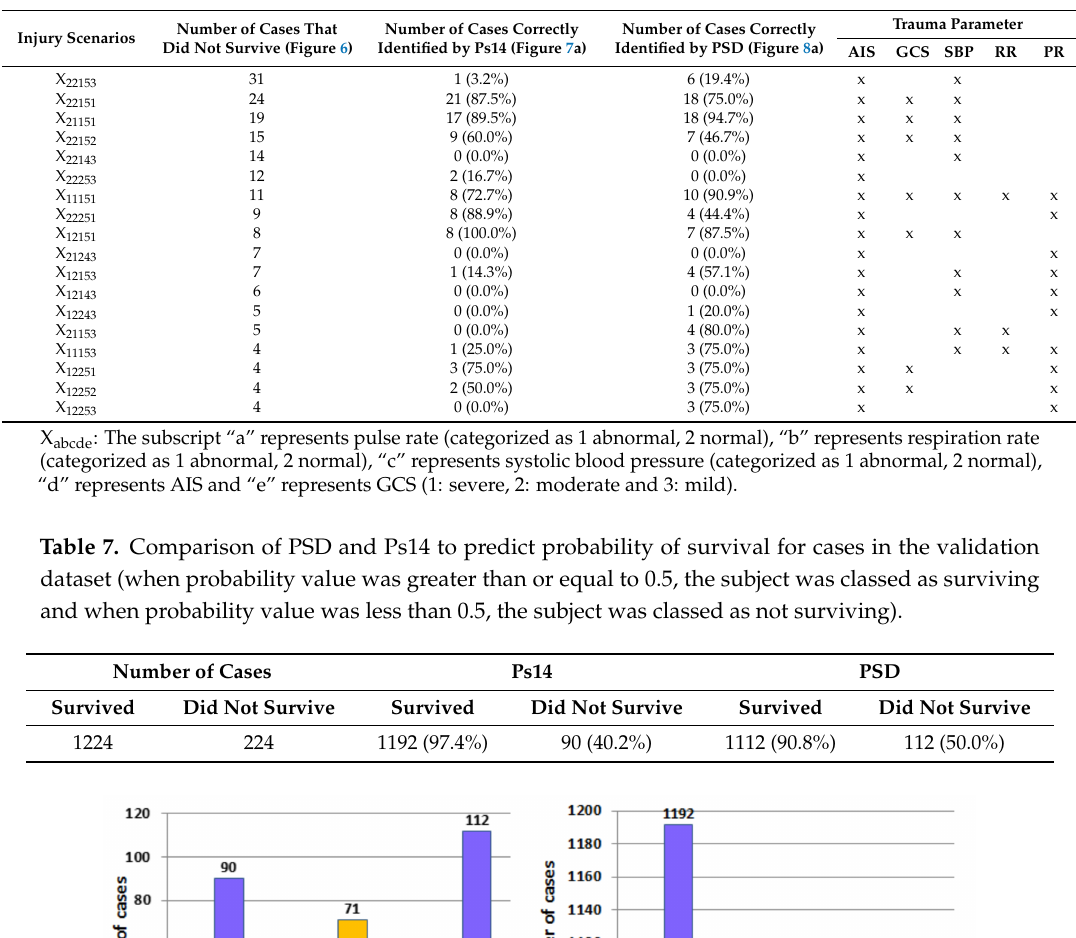
Table 6. Analysis of injury patterns for non-surviving cases included in the validation dataset (the patterns with relatively small number of cases are not shown). An x in the trauma parameter columns indicates abnormal or severe categorization for the related parameter.